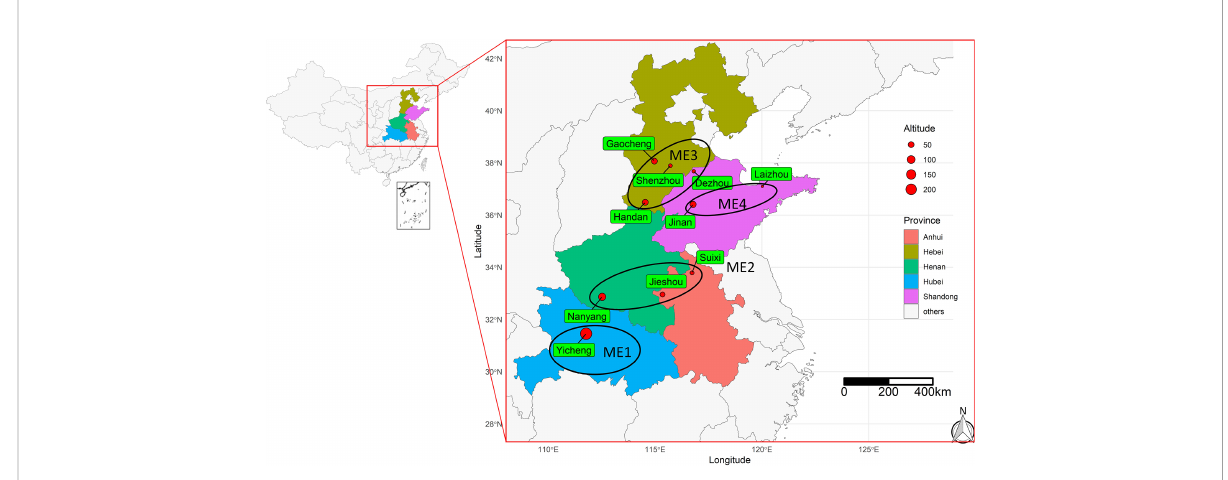
FIGURE 1 Geographical information of the 10 test locations for the trials conducted during 2019 and 2020. The ellipses show the four delineated mega- environments (ME) based on long-term (20 years) climate